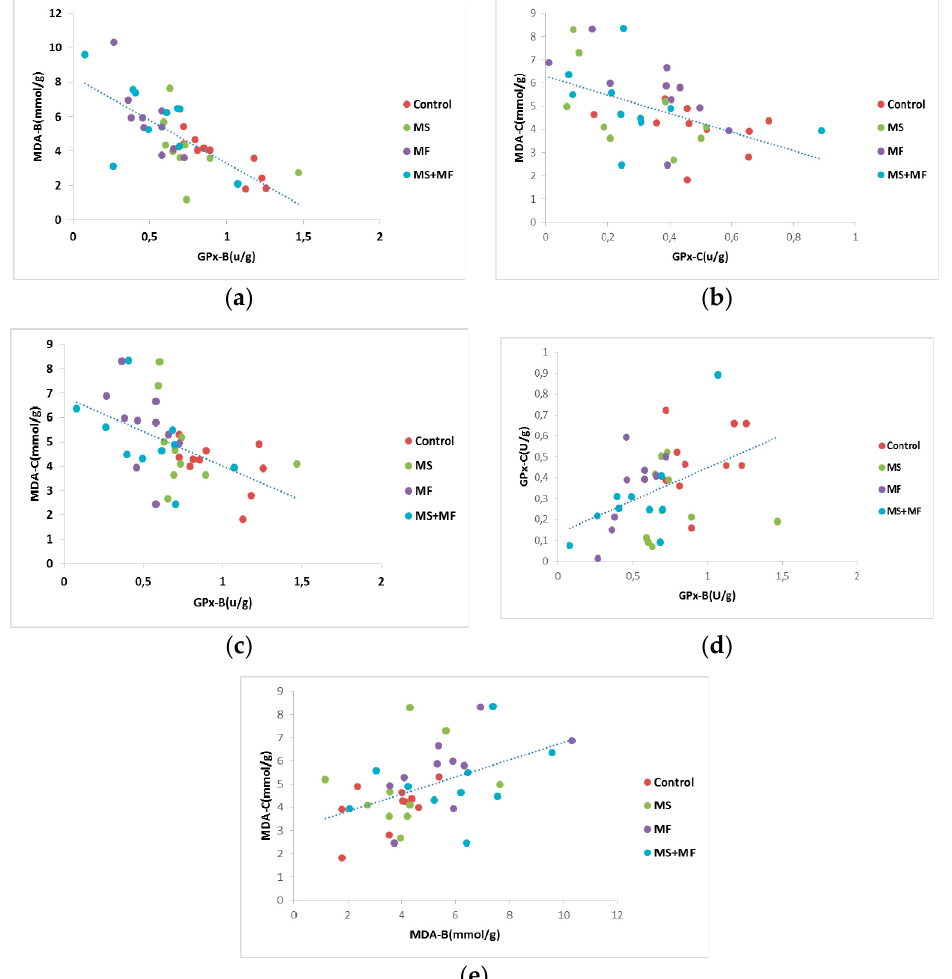
Figure 10. Statistical correlations between oxidative stress parameters in brain and colon: ( a ) brain GPx activity vs. brain MDA levels, ( b ) bowel GPx activity vs. bowel MDA levels, ( c ) brain GPx activity vs. bowel MDA levels, ( d ) brain GPx and bowel GPx activity, ( e ) brain MDA and bowel MDA levels ( n = 40, MDA-B = MDA brain level, GPx-B = brain GPx activity, GPx-C = colon GPx activity, MDA-C = colon MDA level).